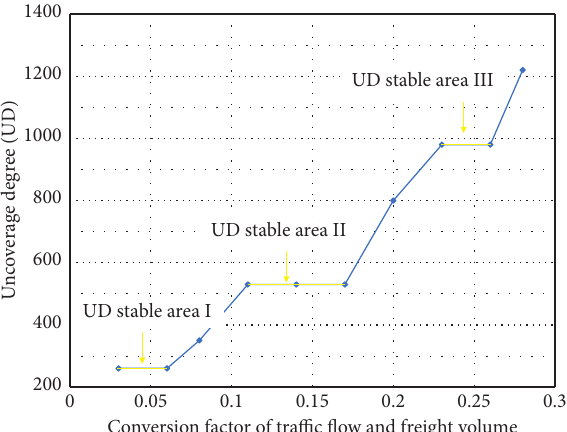
Figure 7: Variation of demand uncover degree by parameter δ .